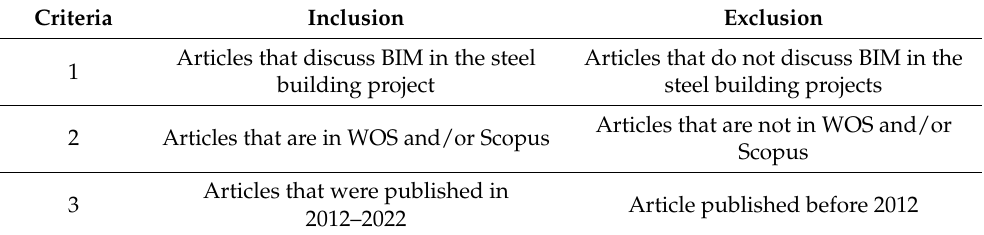
Table 1. Inclusion and exclusion criteria [38].